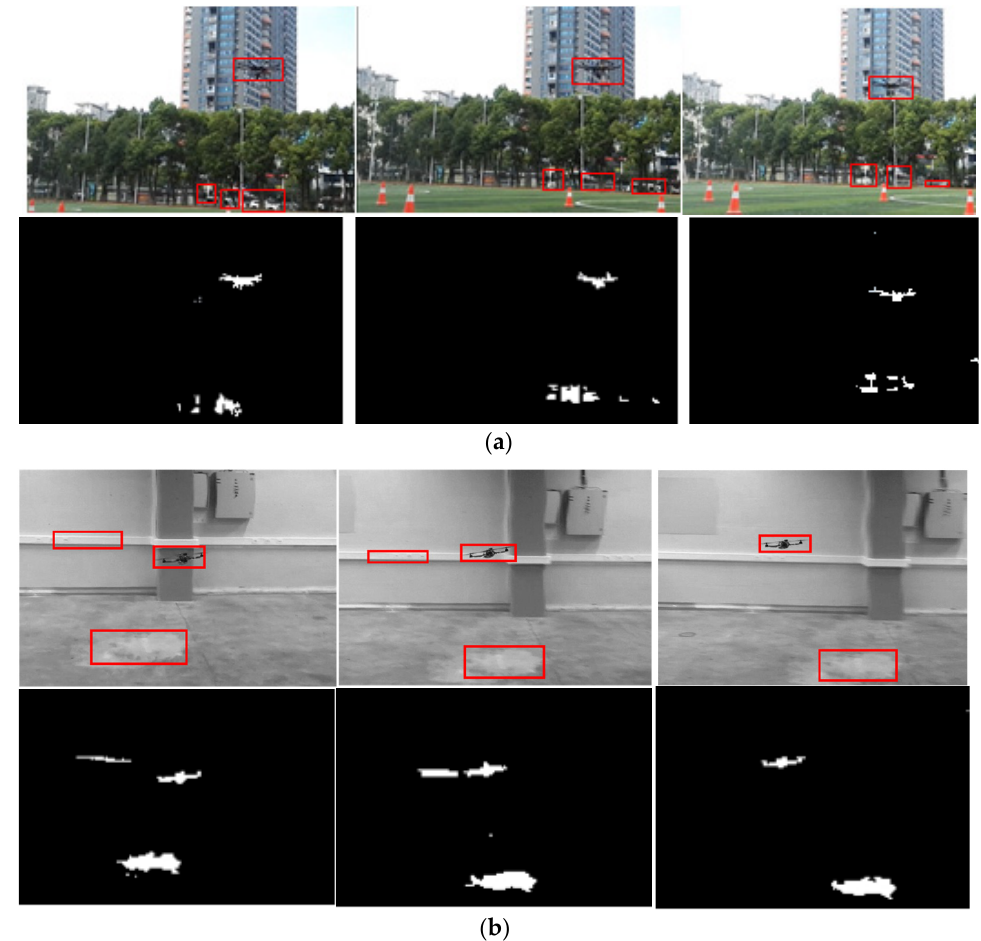
Figure 8. Illustrations of ROIs extraction. ( a ) Urban scene. ( b ) Indoor scene. Figure 8 visualizes the extraction results of ROIs in an urban and indoor scene. The red windows in the top rows are the ROI bounding boxes, and the mask areas in the bottom rows are the ROIs.